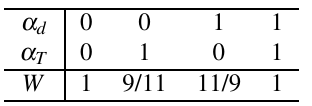
Table 3. Values of the weight W for boundary values of RDM- variables α V and α V sp